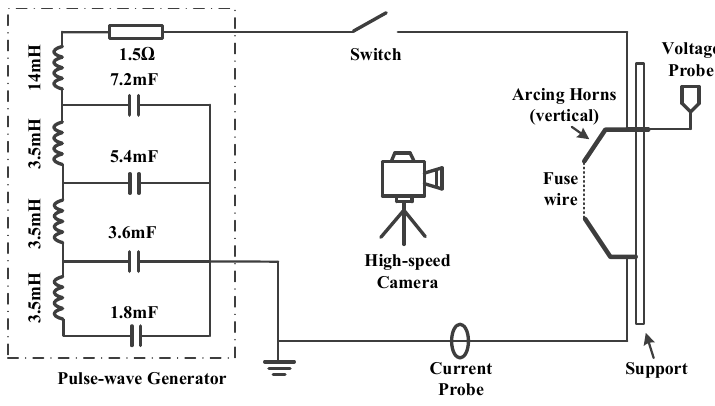
Figure 3. Diagram of experimental system.